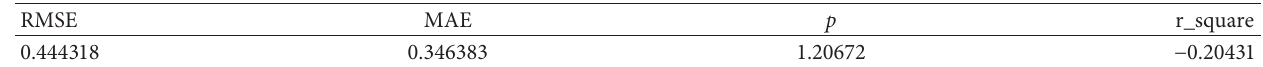
Table 21: Realized volatility prediction evaluation of the Wavenet in test set.